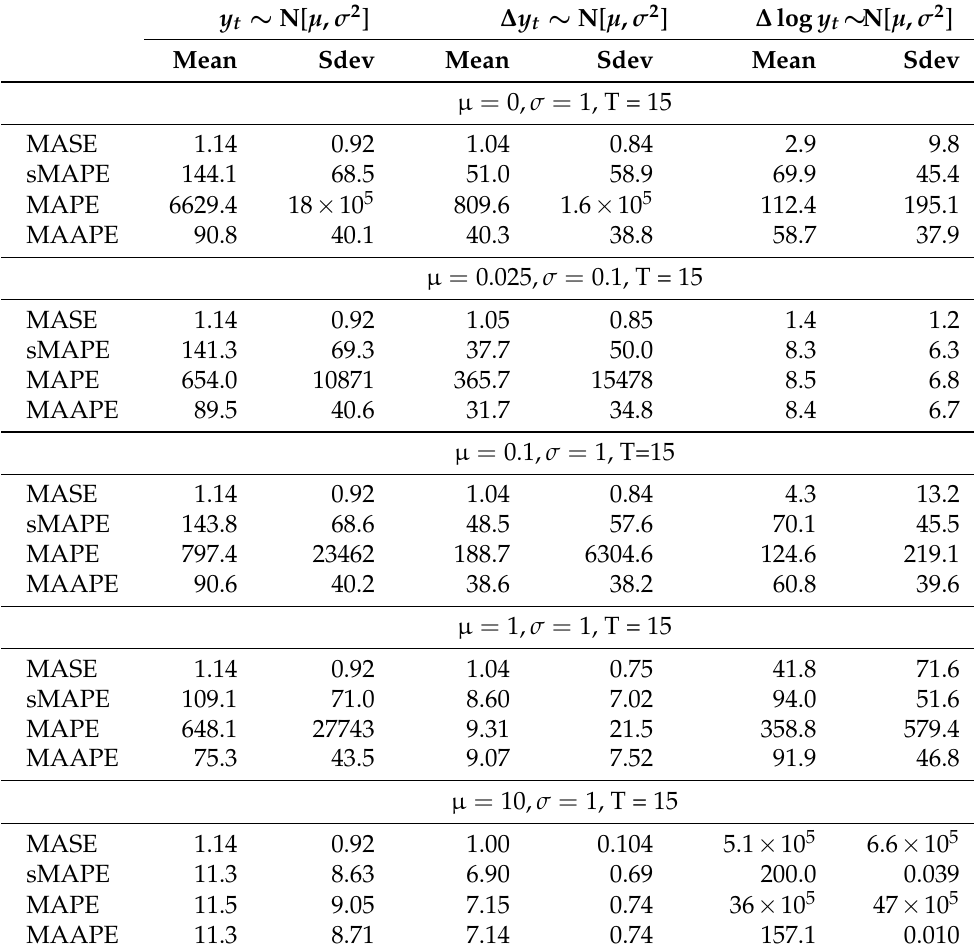
Table A2. Simulated means and standard deviations of MASE, sMAPE, MAPE, and MAAPE for one-step ahead naive forecasts. T = 15, M = 100,000